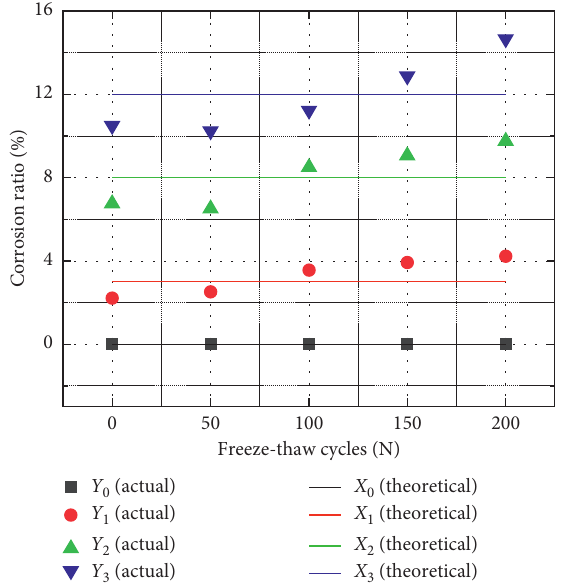
Figure 5: The difference between the actual corrosion ratio and theoretical corrosion ratio.